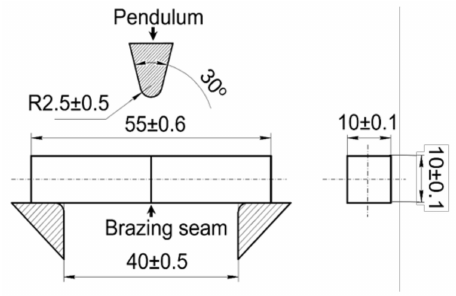
Figure 6. Impact test scheme with